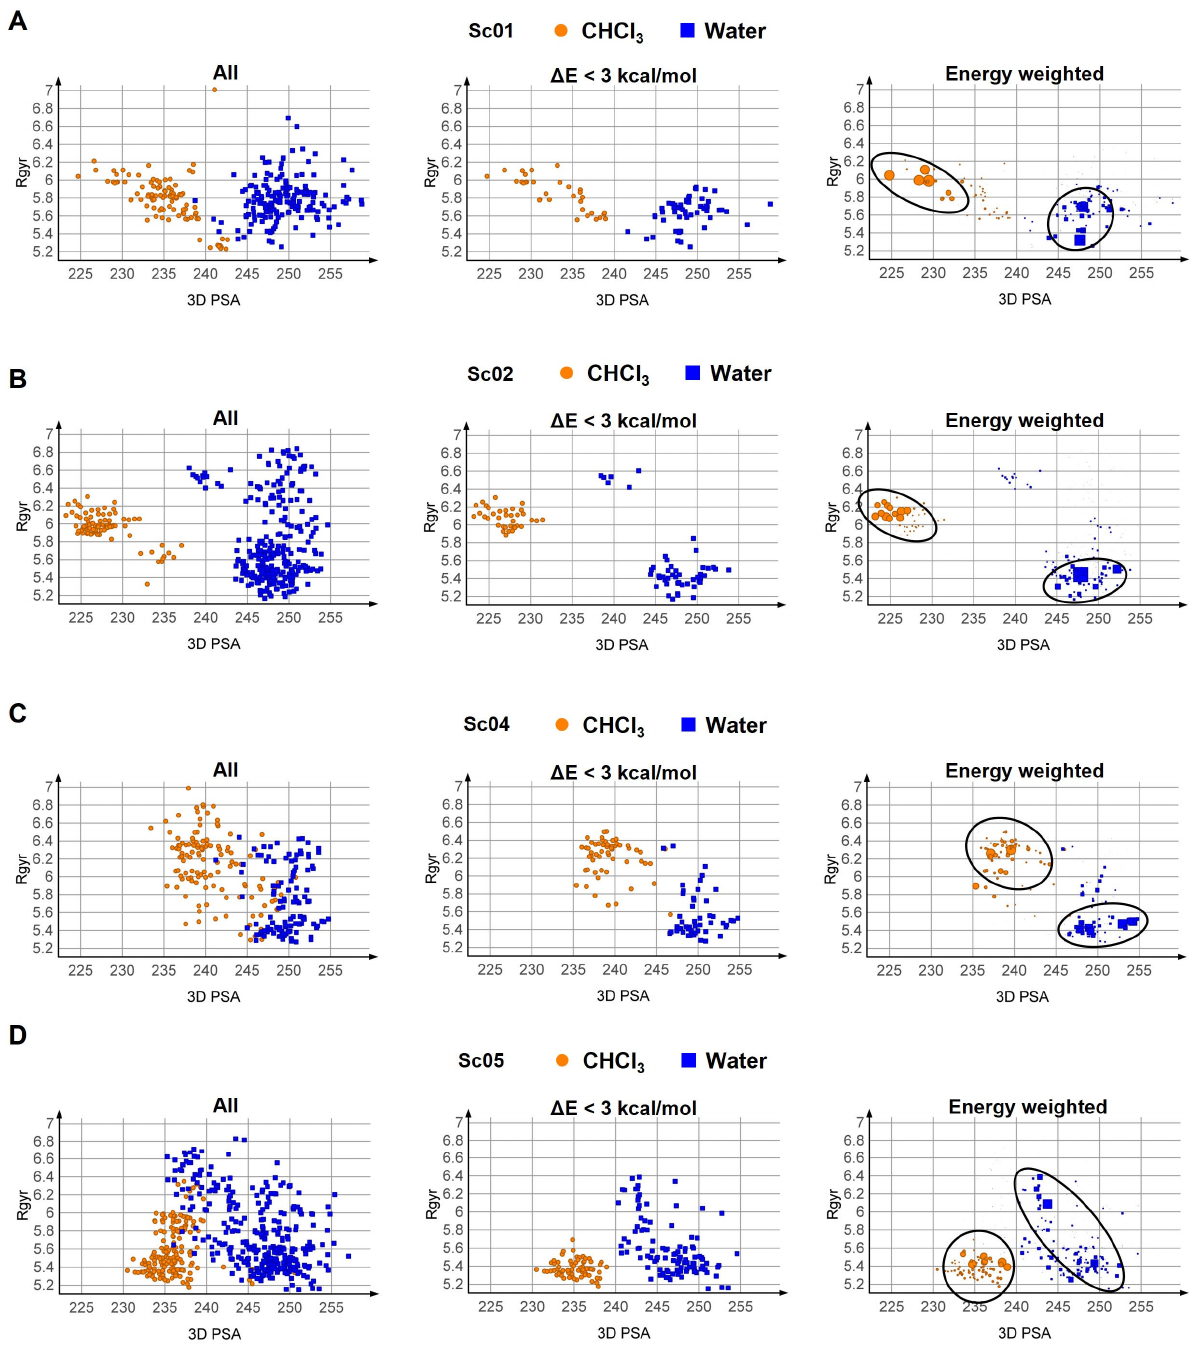
Figure 4. Plots of R gyr vs. 3D PSA for the ensembles obtained with the different protocols. Three protocols for conformational sampling were used in combination with three schemes for selecting the conformations. ( A ) Sc01, ( B ) Sc02, ( C ) Sc04, and ( D ) Sc05. Black circles highlight high-probability conformer groups. Sc03 and Sc06 are not reported since they provided identical ensembles to Sc02 and Sc05, respectively.